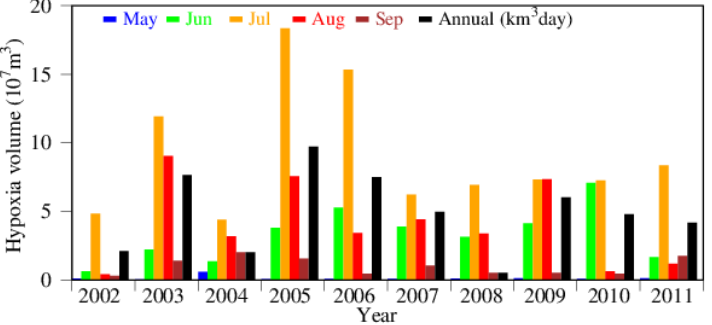
Figure 5. Monthly hypoxia volume (DO ≤ 2 mg L − 1 ) from May through September (color bars) and annual hypoxia volume-days (black bars) from 2002 through 2011.